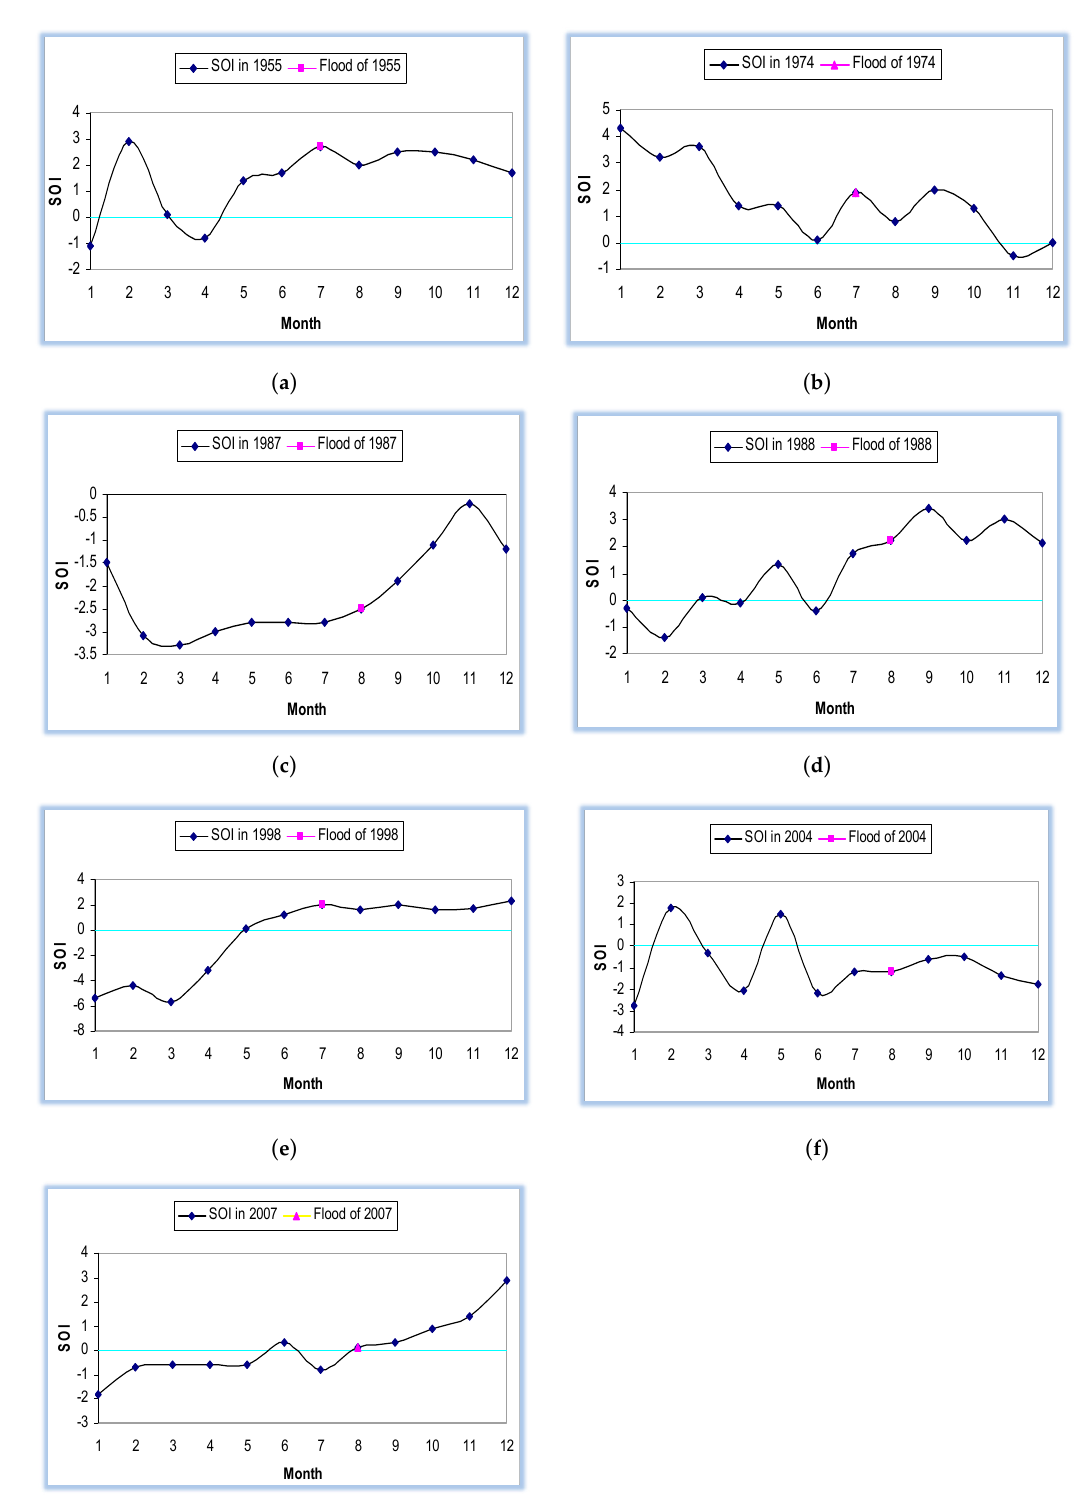
Figure 2. Seven major floods ( a ) 1955, ( b ) 1974, ( c ) 1987, ( d ) 1988, ( e ) 1998, ( f ) 2004, ( g ) 2007 over Bangladesh during ENSO phase. Black line represents the variability of SOI, and green line is the base line where positive value (>0.5) of SOI indicates El Niño, negative value (< − 0.5) indicates La Niña, and rest ( − 0.5 to 0.5) shows the neutral ENSO. Magenta dot indicates the month of the year when flood